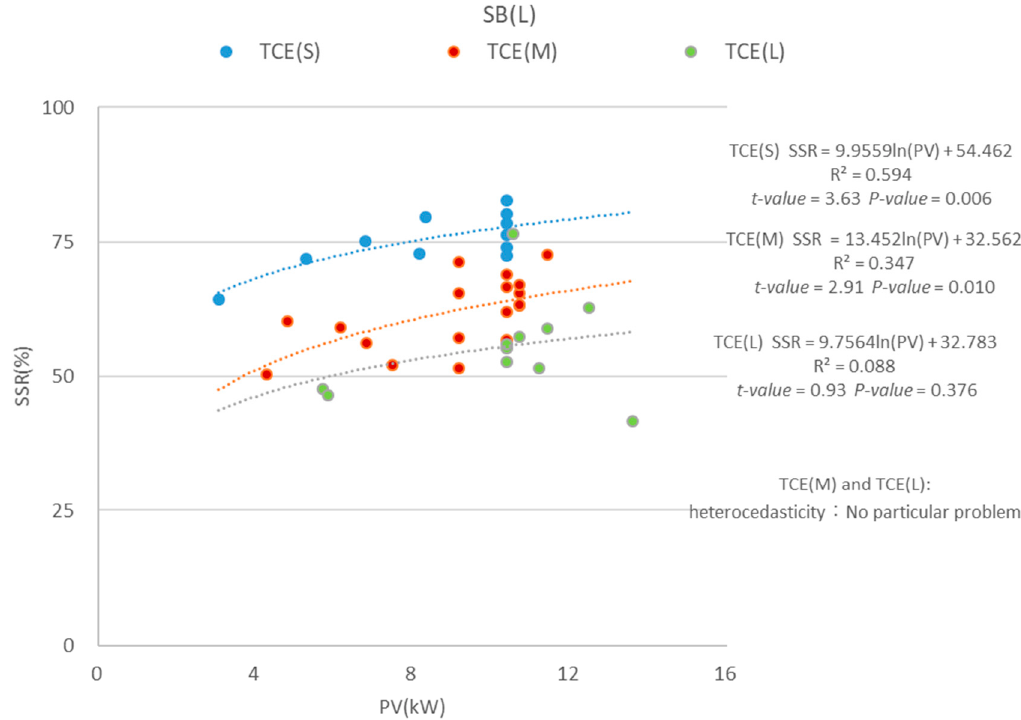
Figure 22. SSR regression equation for each PV capacity by SB (L) GRM and HPWH 100%.